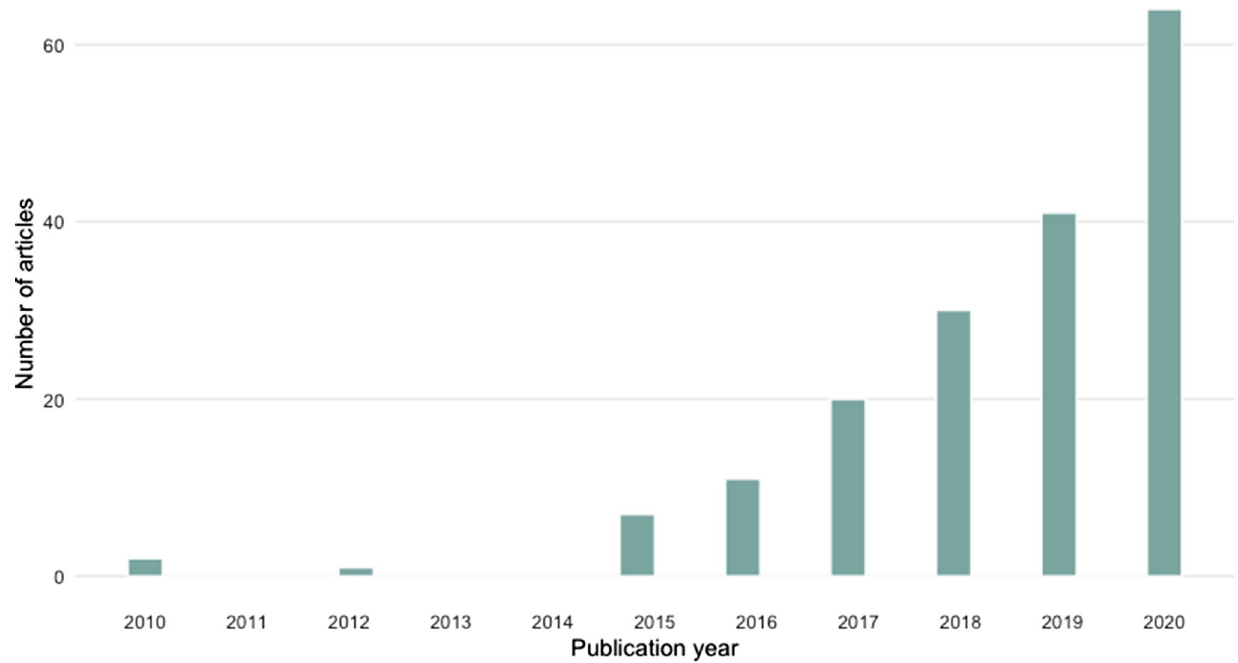
Fig. 3 The number of articles included in the evidence map by publication